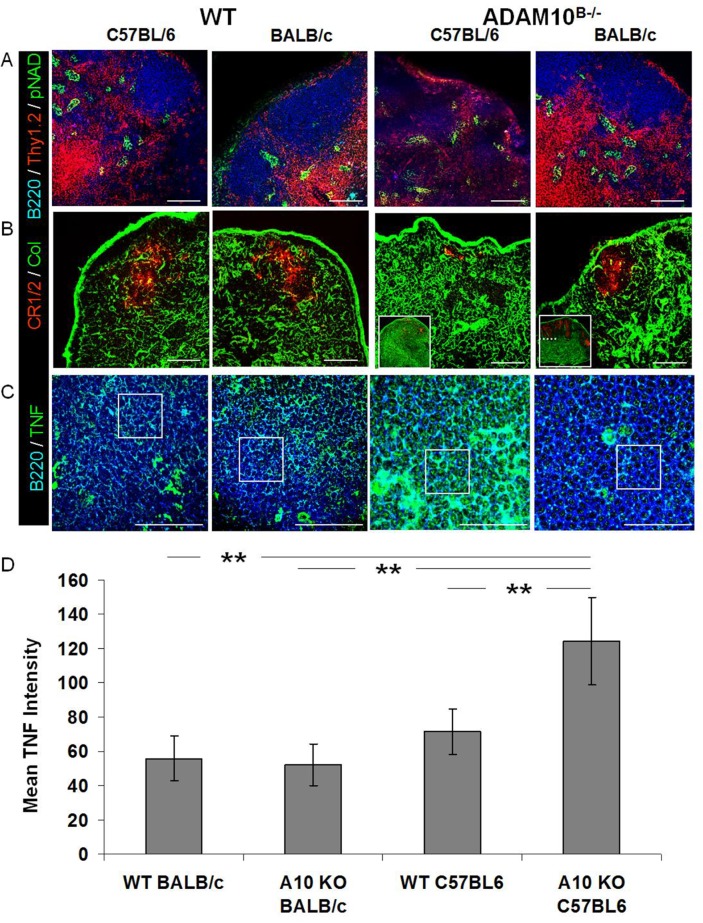
Balb-ADAM10B-/- LN exhibit WT architecture unlike C57-ADAM10B-/- nodes.Naïve LN sections from C57Bl/6 and Balb/c WT and ADAM10B-/-; (A) B cell (blue, B220), T cell (red, Thy1.2), and HEV (green, pNAD); (B) FDC reticula (red,CR1/2), collagen (green), and cortico-medullary junction (dotted line in inset box); (C) TNF staining (green), B cell (blue, B220) follicle. (D) Average TNF staining intensity representing 12 follicle sections per group. Scale bar, 50μm. **p<0.005.